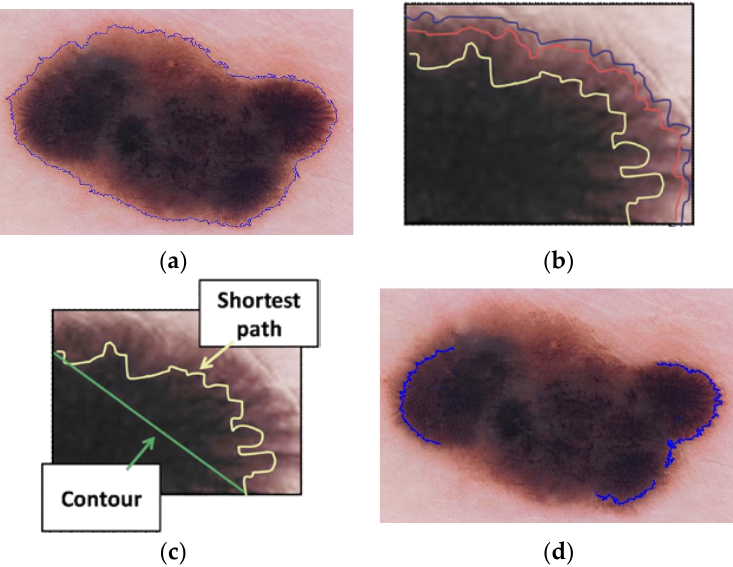
Figure 7. Detection of irregular streaks: ( a ) ELM image and lesion contour; ( b ) the lesion area next to the border segment (blue line) is investigated (color segmentation based on SRM) searching for darkest regions; ( c ) finger-like structures are detected through; ( d ) automatic detection of Irregular